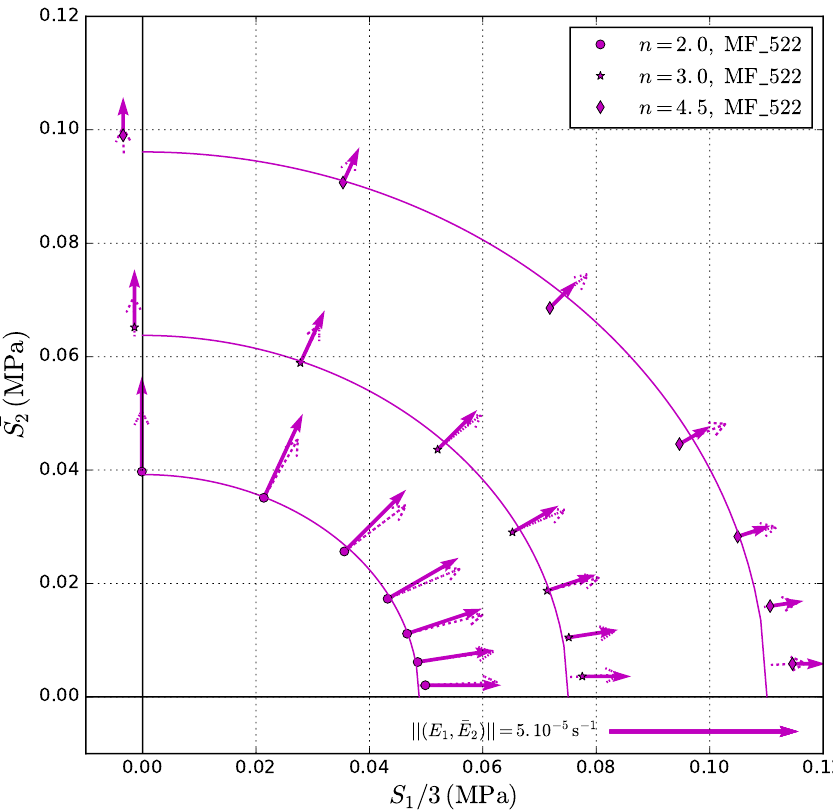
Figure 5. Influence of the exponent n onto the iso-dissipation curves ( P v = P ◦ v ) for the particular snow sample MF_522 . The associated ◦ ,E strain flow vectors (E ◦ 2 ) are represented by solid arrows. Abouaf models are fitted to the numerical points (solid lines) and theoretical 1 values of strain flow vectors are shown (dashed arrows).